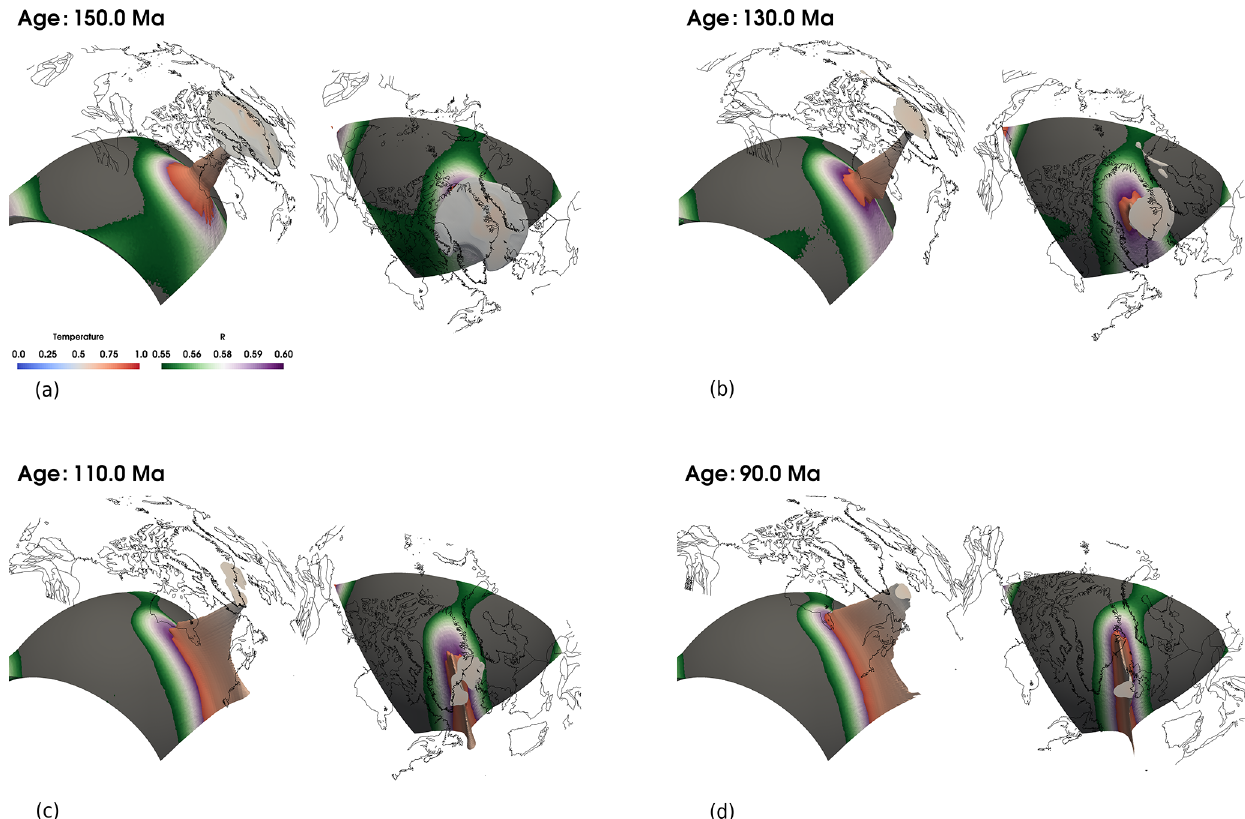
Figure 3. (a) The non-dimensional temperature field above layer averages, ∂T , is plotted as isosurfaces (coloured by non-dimensional temperature) in the range 0.08–0.3, delineating the model plume erupting at 150Ma in case C2 (see Table 2). The top 200km is excluded from the rendering to avoid visual clutter. Non-dimensional topography of the 75% chemical concentration isosurface, above the CMB, is also shown and reconstructed coastlines are shown for geographical reference. (b–d) Same as in (a) , but at labelled